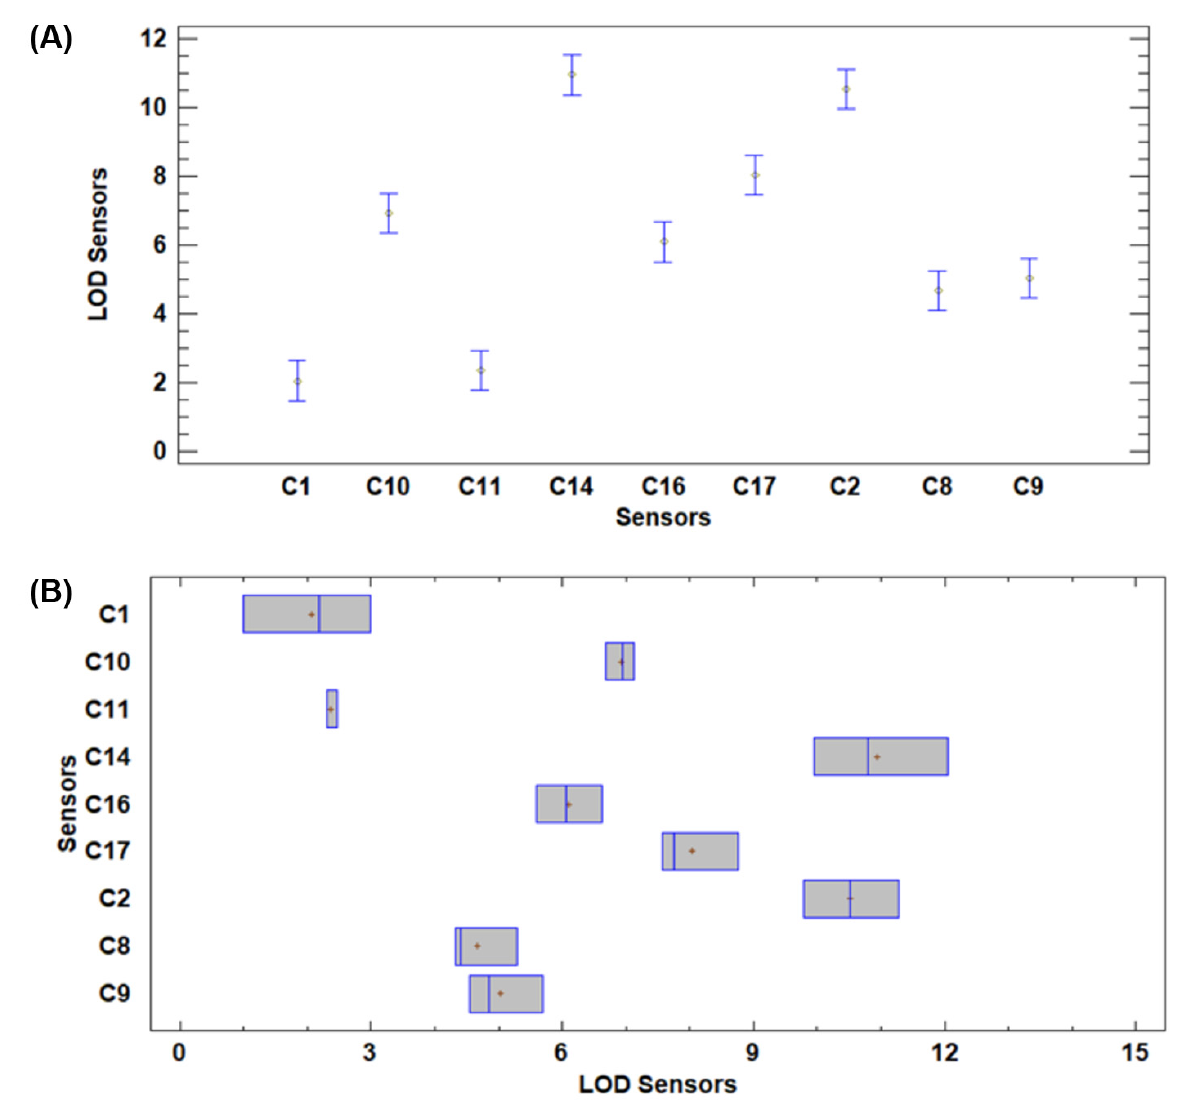
Figure 5. ANOVA graphs referred to the LOD (µM) and sensors prepared, confidence intervals for the mean (Fisher Least significance difference): ( A ) mean graphs and ( B ) box and whisker plot. SNGC/AuNPs (drop) (C1), SNGC/PEDOT-SV (C2), SNGC/PEDOT-SV/AuNPs (drop) (C8), SNGC/PEDOT-SV/[CNTsAuNPs] (C9), SNGC/PEDOT-SV/CNTs-AuNPs (C10), SNGC/PEDOT-SV (C11), SNGC/PEDOT-SV/[CNTsAuNPs] (drop) (C14), SNGC/PEDOT-SC/CNTs (C16), SNGC/PEDOT-SC/AuNPs (drop) (C17).